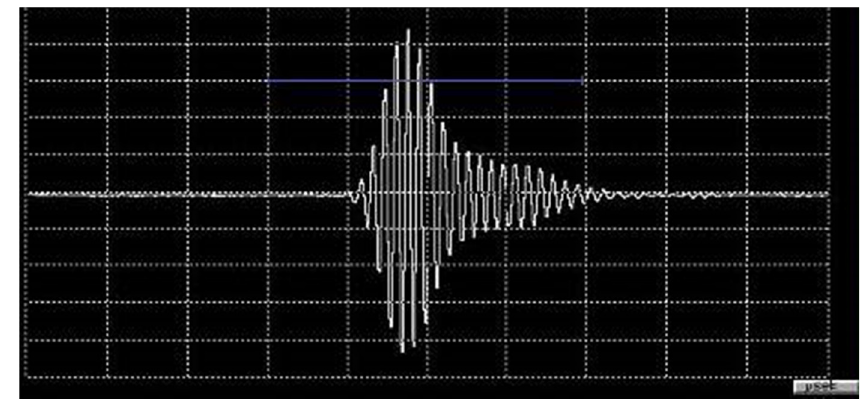
Figure 3: Example of an ultrasonic surface wave pulse.